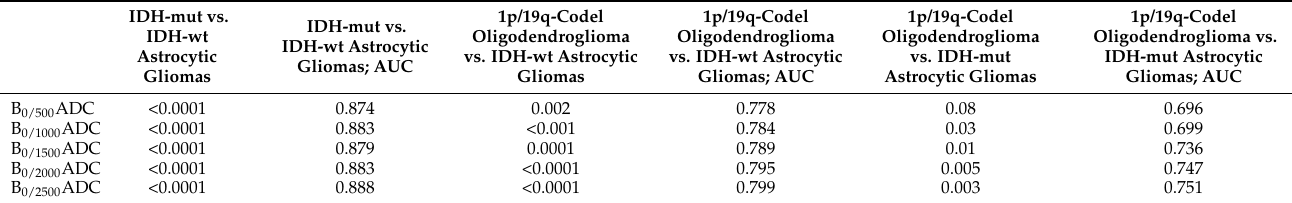
Table 2. Statistical differences ( p -values) and AUC from ROC analysis of the three glioma subgroups for B 0 ADC-evaluation: AUC, area under the curve; ROC, receiver operation characteristic; MK, mean kurtosis; MD, mean diffusivity.